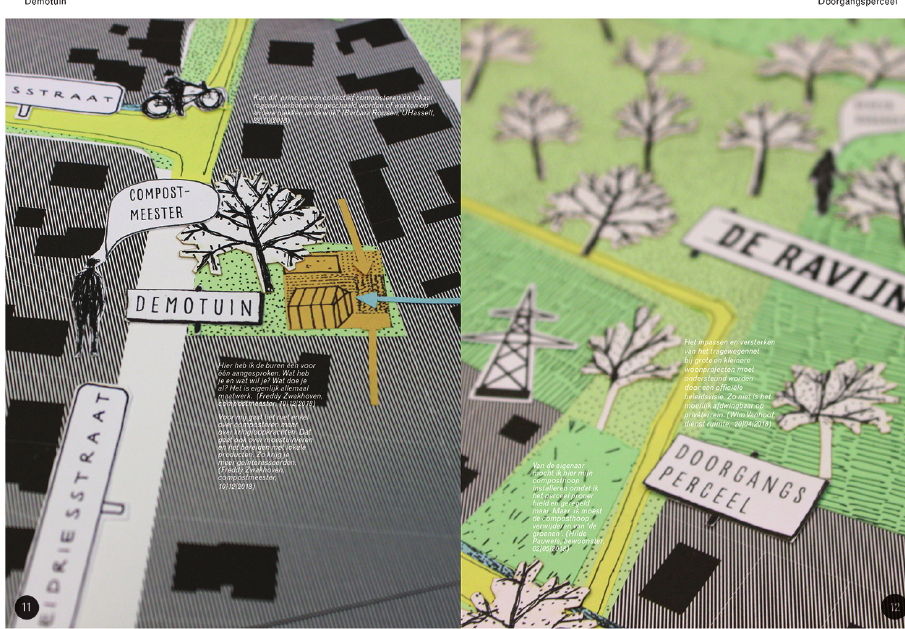
Figure 2. Double page from the atlas’ first section ‘places’ with the ‘neighbour compost network’ and the ‘passage plot.’ Source: Anse Arits, Laura Enkels, Julie Polus, Alexander Verlaak, and Barbara Roosen (based on the digital topographic map of Flanders, GRB